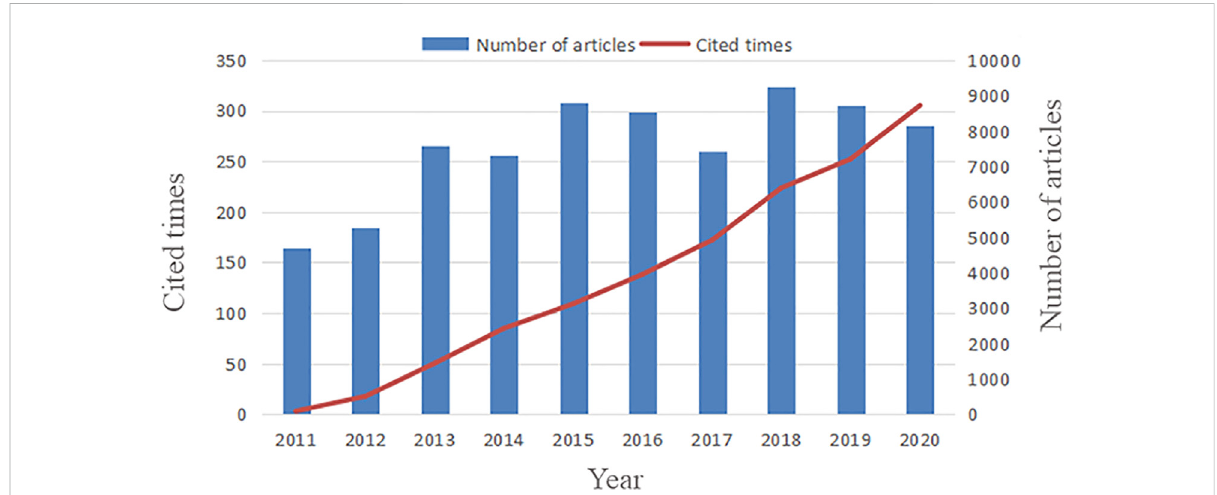
FIGURE 2 Trends in the growth of publications and the number of cited articles worldwide from 2011 to